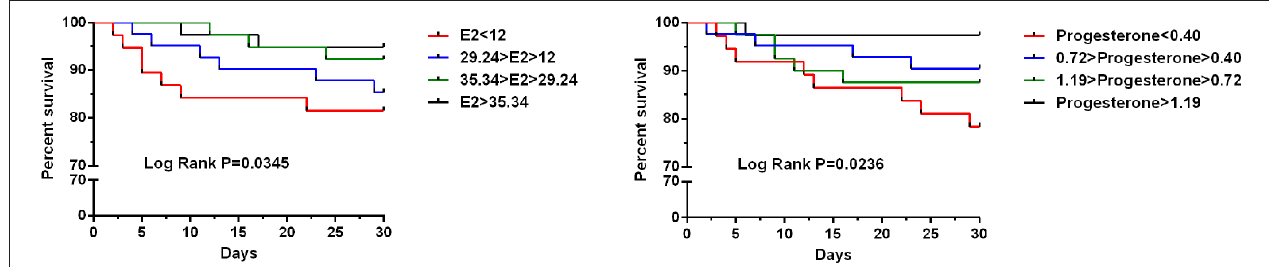
FIGURE 2 | Kaplan–Meier curve stratified by E2 and progesterone according to quartiles regarding 30-day mortality for older women undergoing hip fracture surgery.